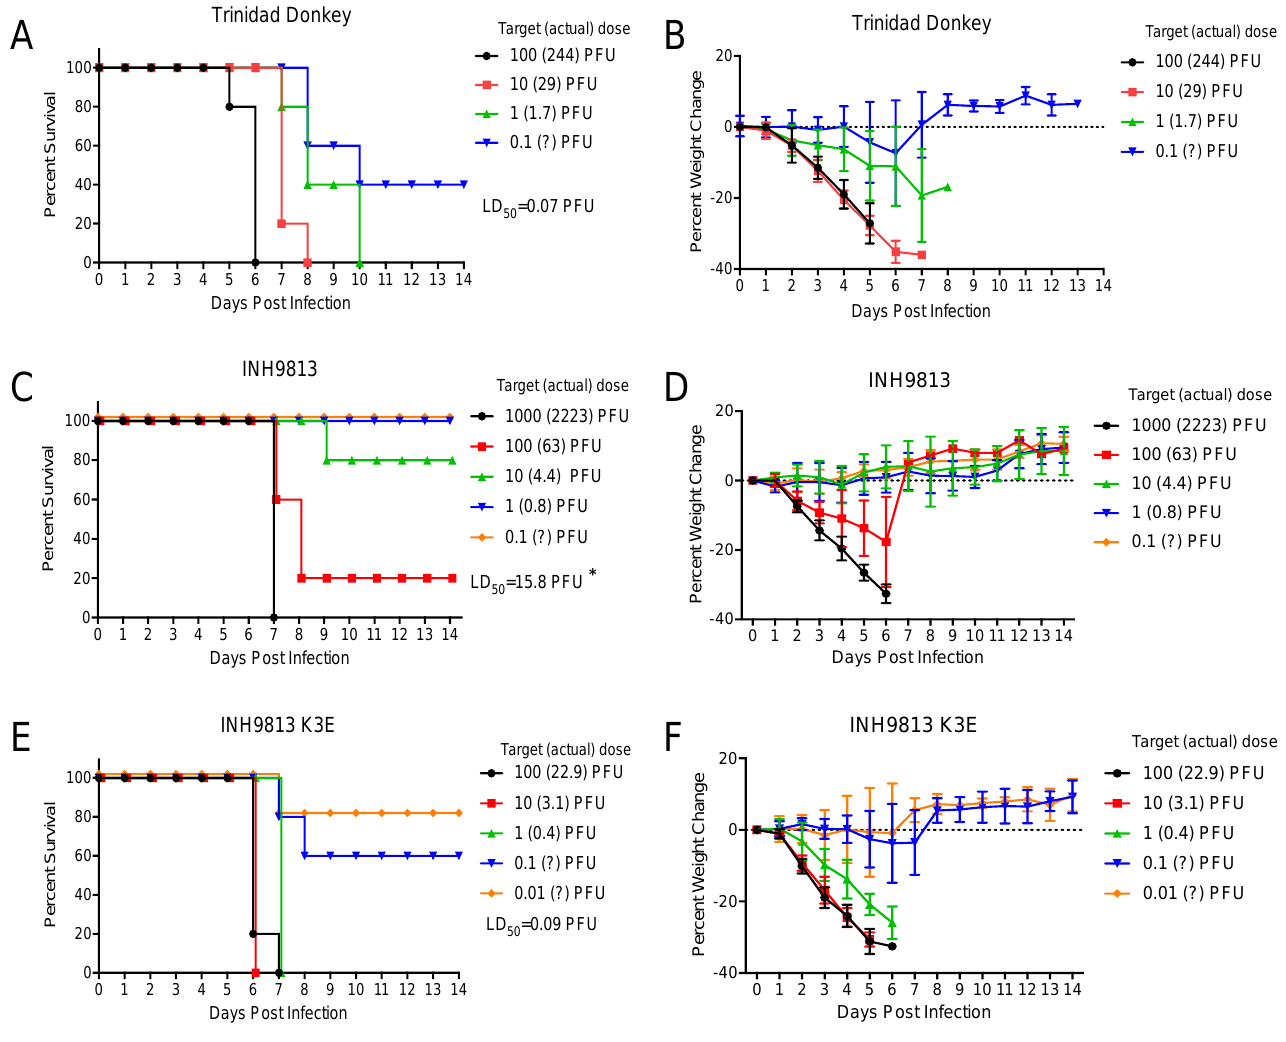
Figure 7. Aerosol LD 50 mortality curves ( A , C , E ) and weight loss data ( B , D , F ) for 4–week–old CD–1 mice infected with each indicated virus. Values with question marks are estimates of aerosol dose. Aerosol LD 50 infections included 5 or 10 mice per group and were replicated with at least four dilutions per experiment. Error bars are standard deviations. * = LD 50 V3000 vs. INH9813 p <